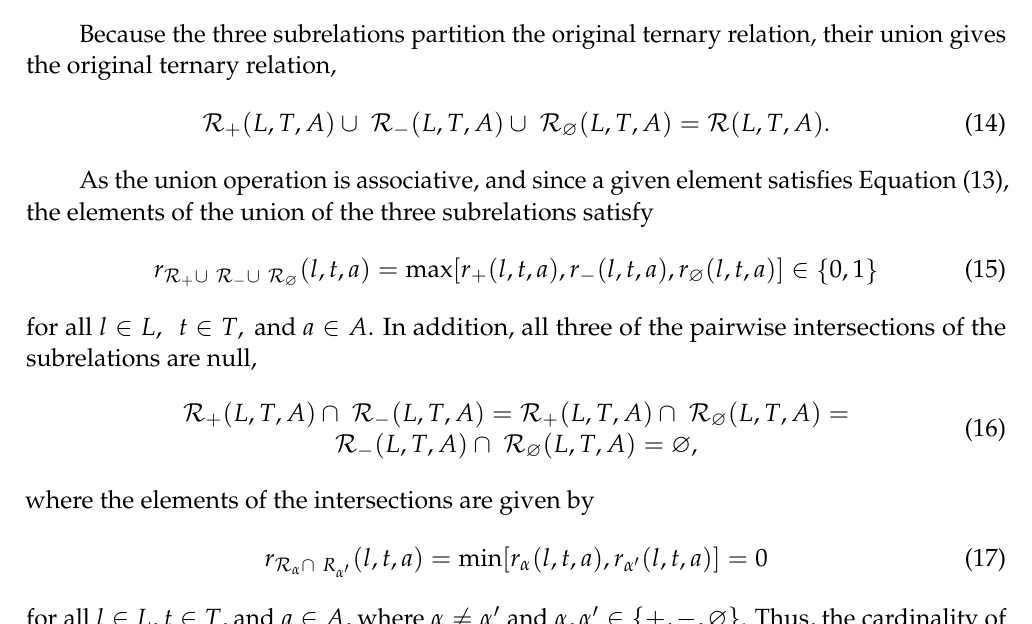
a + -Sheet a − -Sheet a ∅ -Sheet